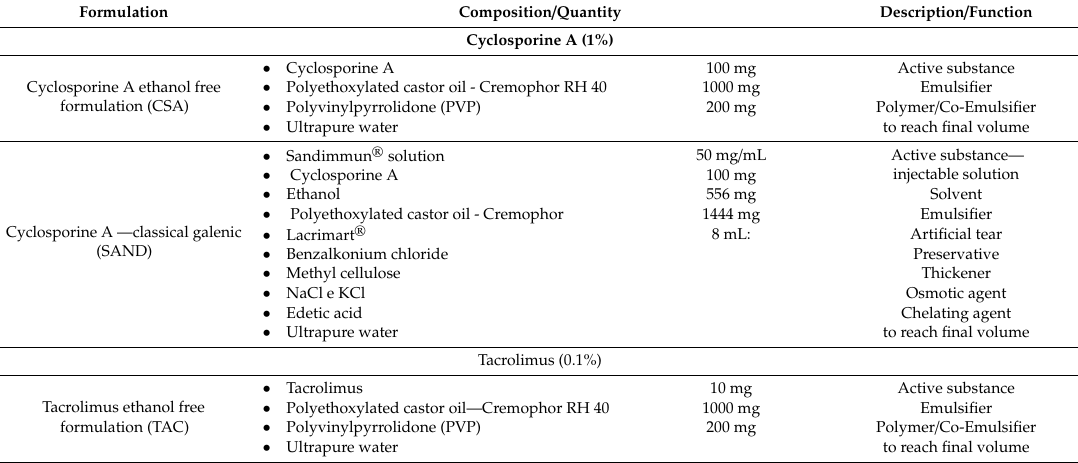
Table 1. Composition of Cyclosporine A- and Tacrolimus-based galenic